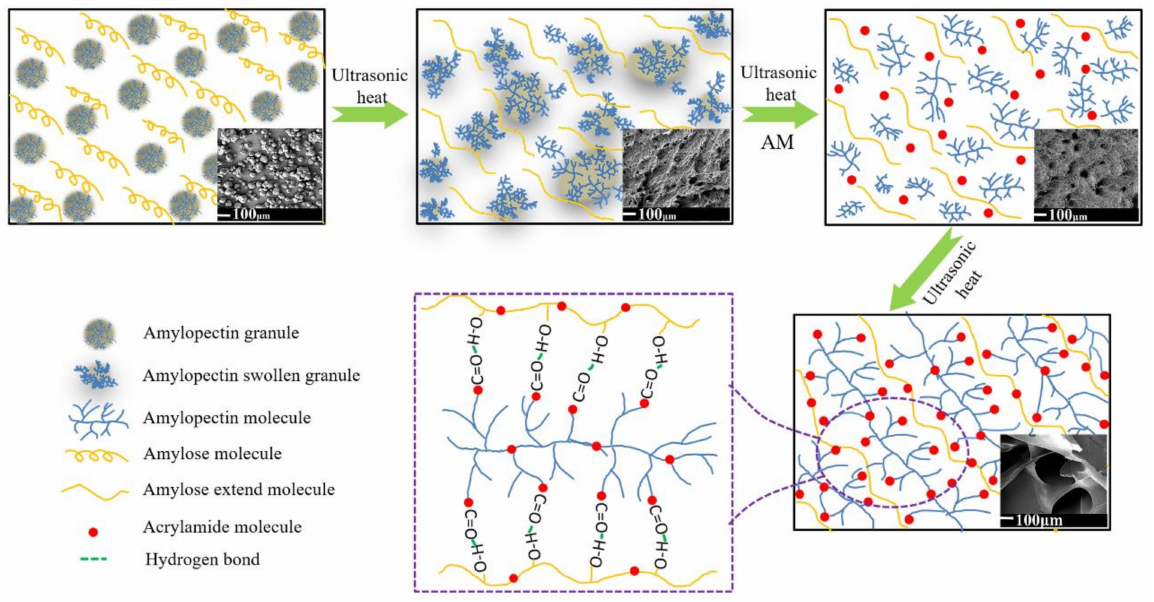
Figure 1. Schematic of amylose/amylopectin synergistic regulation of gel